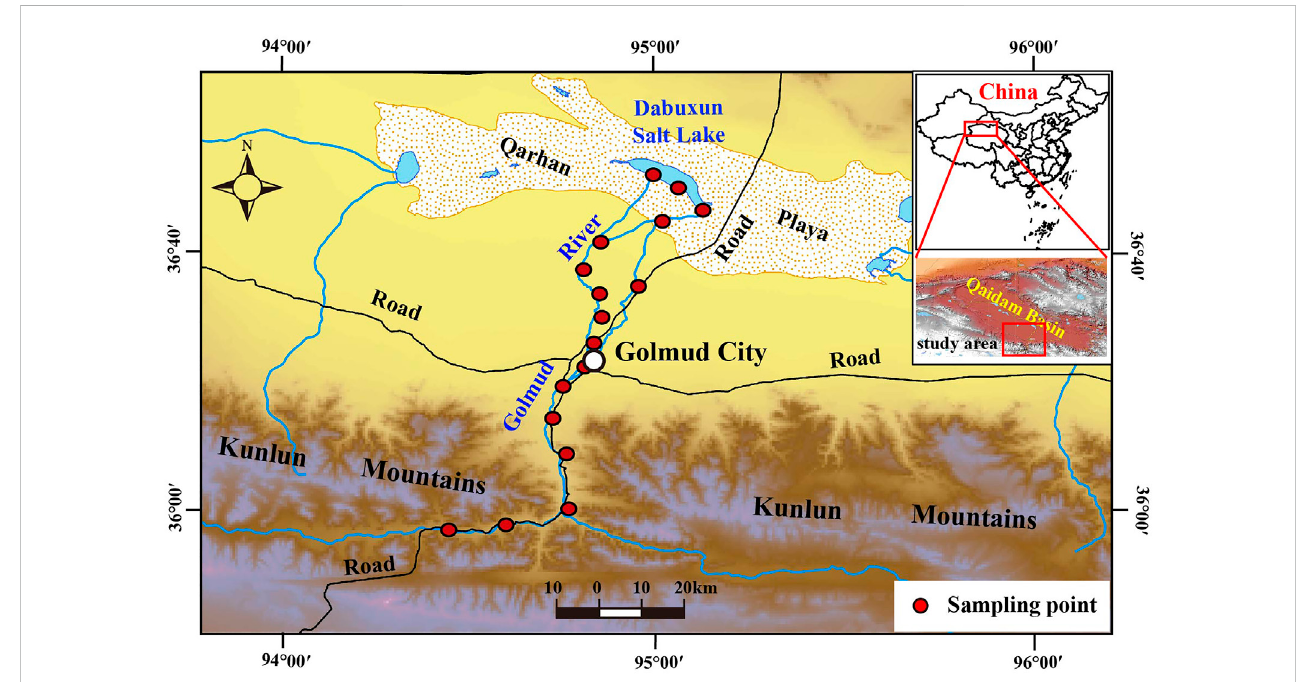
Location map of the study area and the surfacewater and sediment sampling